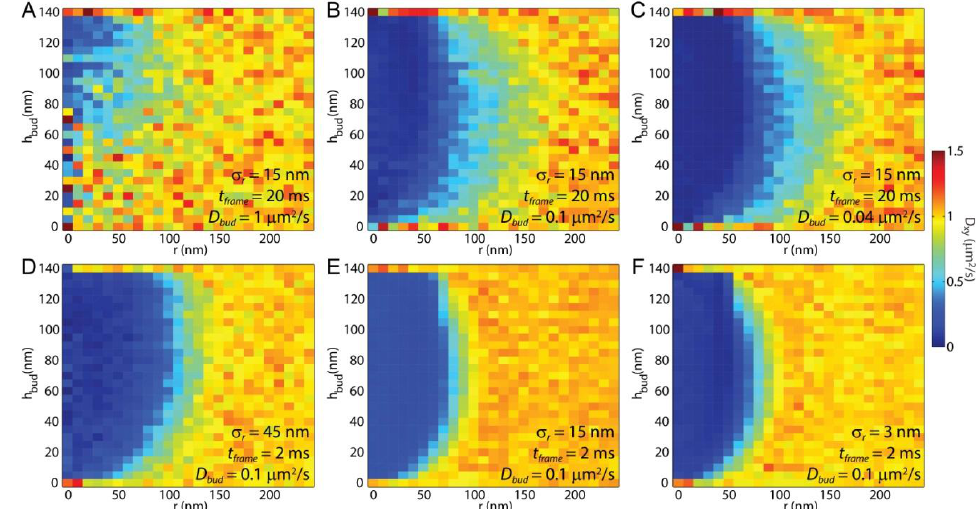
Figure 5. Azimuthal averaging of the spatial mapping of D xy around a bud (i.e., Figure 4) improved the data statistics and enabled easier comparison of D xy versus distance from the bud center ( r ) and h bud . Simulated SPT results for D xy are presented with varying σ r , t frame, and D Bud . ( A ) When D Plane = D Bud = 1 μm 2 /s and, the single molecules maintain a uniform average local speed through the membrane, and the observed variations in D xy were due to the tilt of the membrane; ( B , C ) As D Bud decreased to 0.1 or 0.04 μm 2 /s, the bud became increasingly apparent at all h bud ; The ( D – F ) significant improvements in the resolution of D xy were obtained by decreasing t frame , even at the expense of increasing σ r ; ( F ) Differences in Dxy may be observed across the bud, including slowing at the vertical edge of the bud.